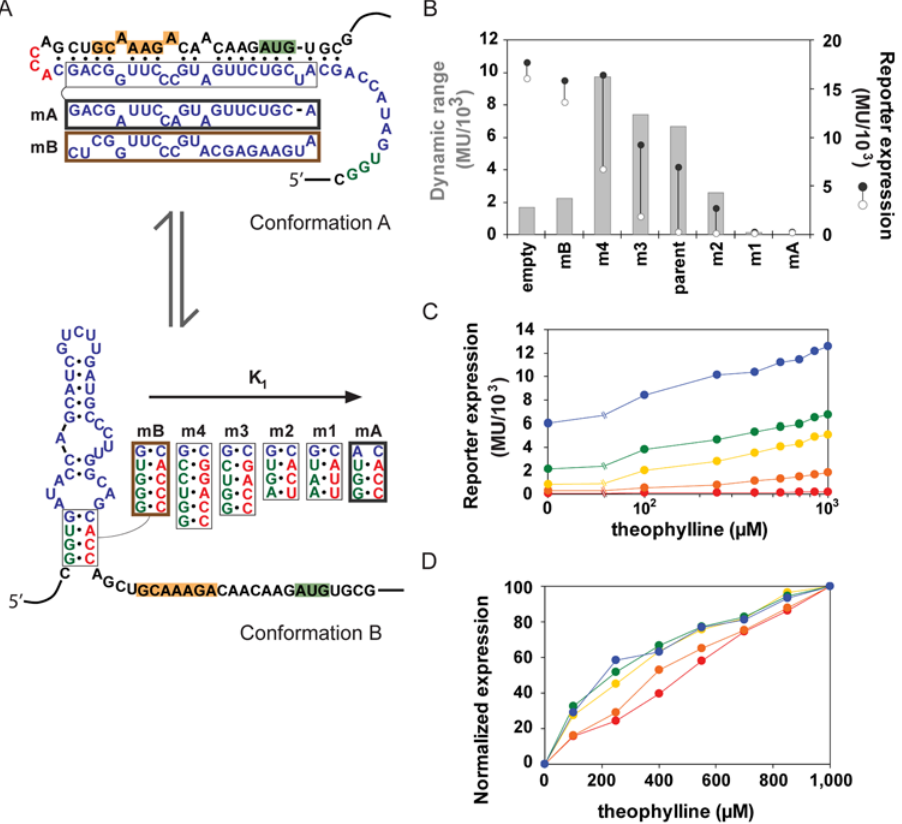
Figure 6. Mutational analysis of a synthetic riboswitch supports model predictions. (A) Mutations made to the aptamer stem of the parent synthetic riboswitch (m1–4) are anticipated to solely modulate conformational partitioning (K 1 ). The theophylline-responsive riboswitch controls Tn10- b -Galactosidase levels through RBS sequestration, thereby repressing translation. Mutations were also introduced to lock the riboswitch in either conformation A (mA) or conformation B (mB). The RBS and start codon are highlighted in orange and green, respectively. (B) b -Galactosidase assay results are reported in Miller Units (MU) for each riboswitch variant in the presence ( N ) or absence ( # ) of 1 mM theophylline. Dynamic range ( g ) is calculated as the difference between high and low expression levels, where all values were below the theoretical maximum of 15,600 MU as determined by the difference between mB with theophylline and mA without theophylline. The positive control construct (empty) harbors only the RBS and aptamer basal stem. A slight increase in b -Galactosidase activity was observed in the presence of theophylline for the control construct. (C,D) Theophylline response curves for riboswitch variants: parent (yellow), m1 (red), m2 (orange), m3 (green), and m4 (blue). (C) Raw data and (D) normalized data illustrate the predicted shift in both basal levels and EC 50 for increasing stabilization of conformation B. Data represent independent measurements of triplicate samples, where the standard error was below 5% of each mean value.